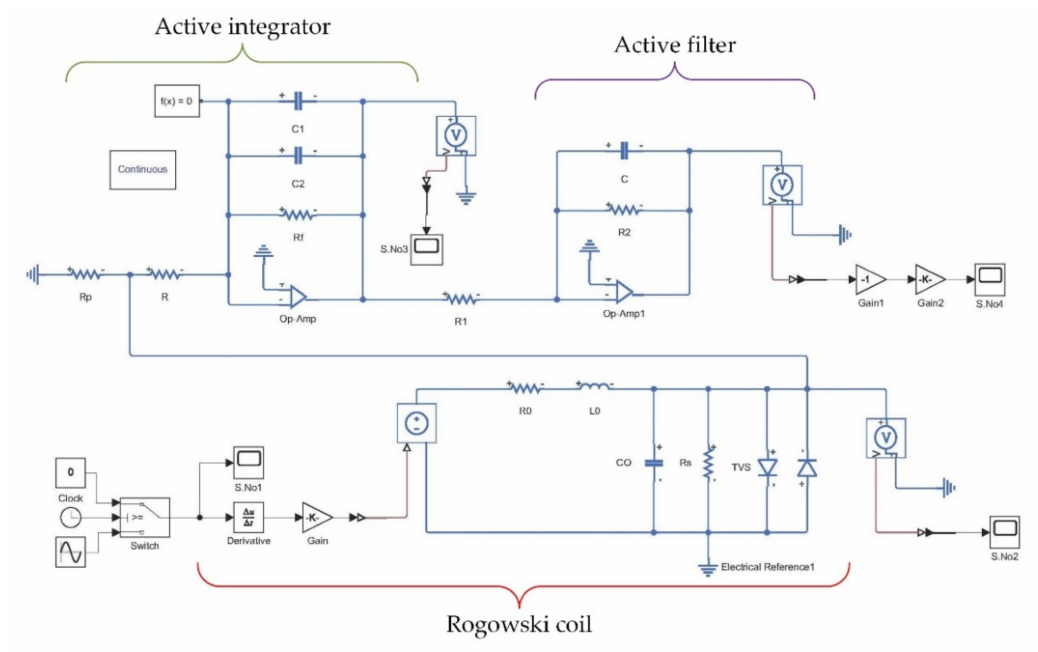
Figure 5. Simulation circuit of the Rogowski coil and integral filter.